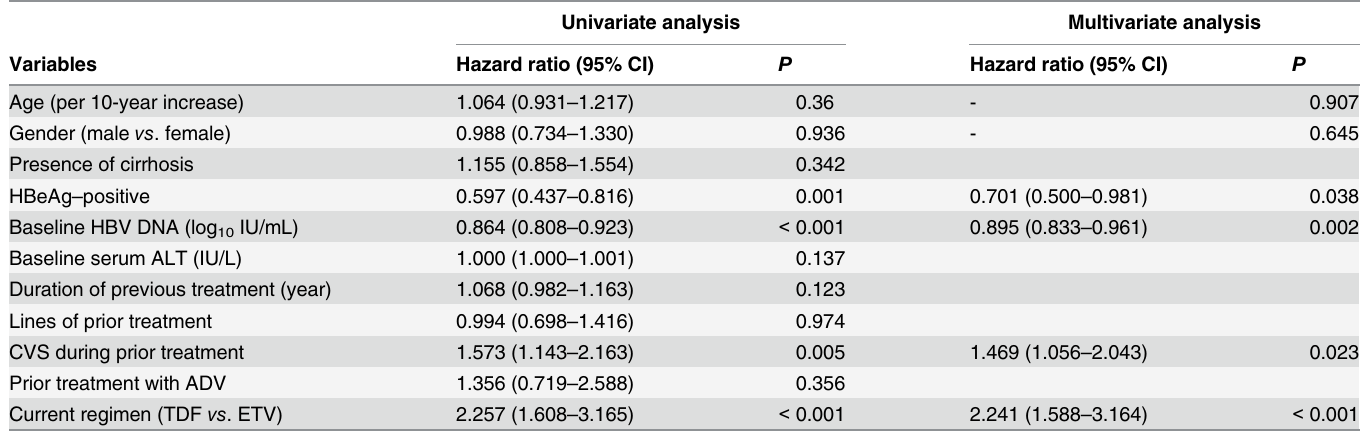
Table 2. Univariate and multivariate analyses of factors associated with complete virologic suppression.